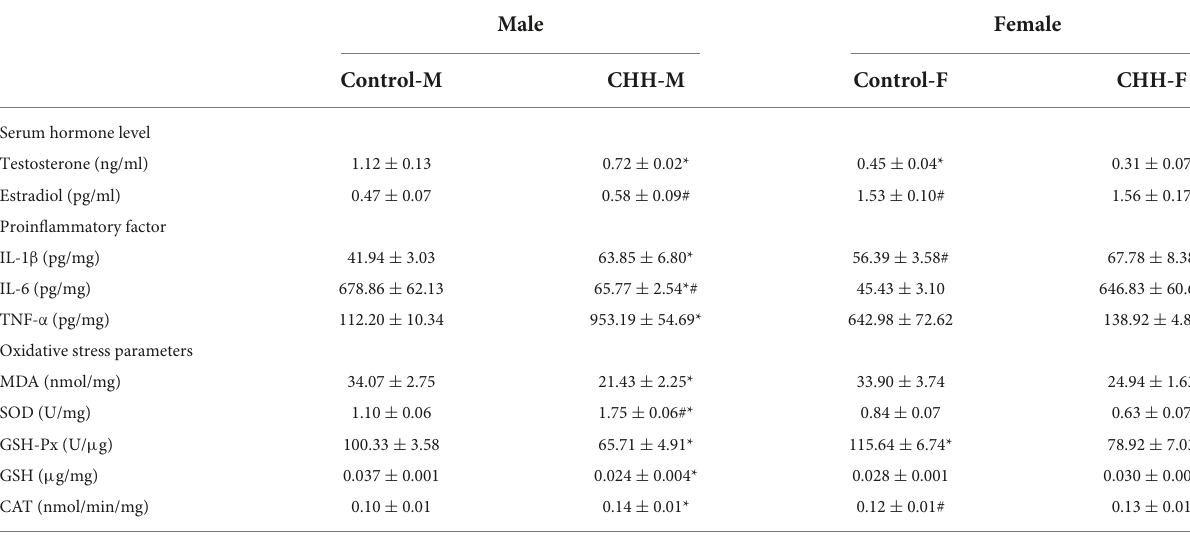
TABLE 3 Initial and final body weights, sex hormone, inflammatory factors, and oxidative stress parameters in male and female rats with or without CHH